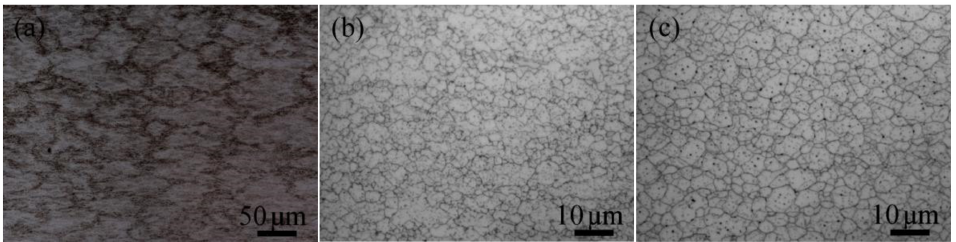
Figure 13. Microstructures of M50 deformed at 0.1 s − 1 under different deformation temperatures: ( a ) T = 950 ◦ C; ( b ) T = 1050 ◦ C; and ( c ) T = 1150 ◦